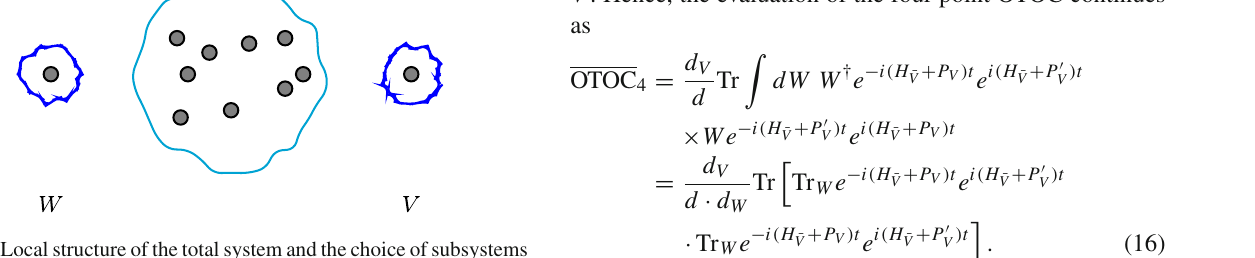
Fig. 4 Local structure of the total system and the choice of subsystems in the local 4-point